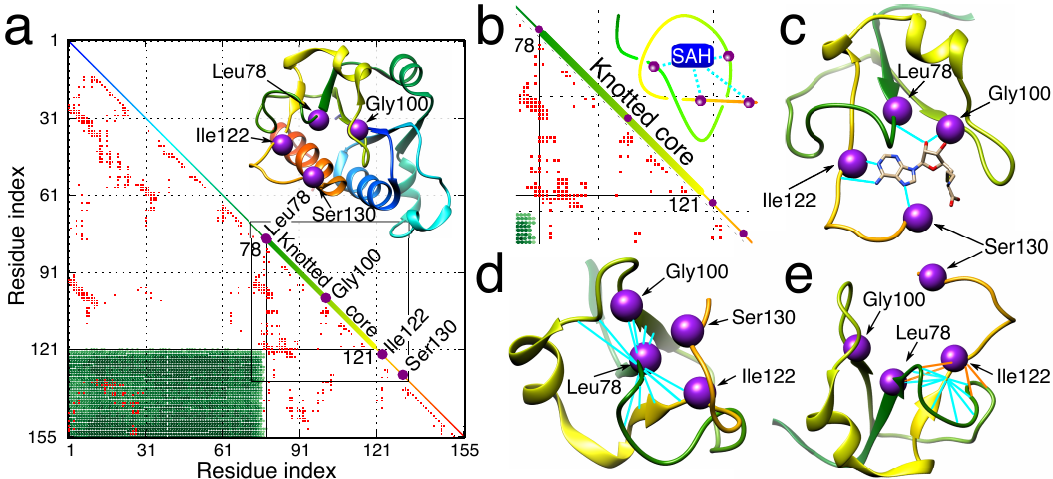
Figure 8. The example of knot-induced advantages for function. ( a ) The knot fingerprint matrix of TrmL methyltransferase with the ligand binding residues denoted by purple dots in the diagonal. The green rectangle denotes the extent of the knotted core. The core is also shown in the diagonal (thick line). The red dots denote the inter-residue contacts. In the inset, the structure of TrmL with the binding residues is marked. The colors in the diagonal correspond to the protein structure. ( b ) The magnification of part of the matrix in (a) (in the square) with the scheme of ligand (SAH) binding. The ligand binding residues are located in or in the vicinity of the knotted core of the protein. ( c ) Structure of the ligand bound to the enzyme. ( d , e ) The binding residues located in the termini of the knotted core. The knot enforces a high inter-residue contact density of binding residue and location on the verge of the hydrophobic core of the enzyme, which supports the ligand binding and enzymatic activity of the residues. Figure used with permission from